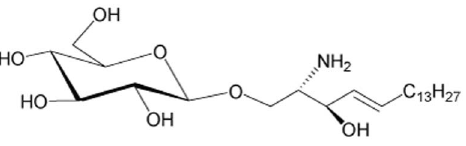
Figure 1. Chemical structure of Glucosylsphingosine. This substance was only analysed by HPLC-MS/MS with high sensitivity and specificity of diagnosing GD. doi:10.1371/journal.pone.0079732.g001 PLOS ONE |